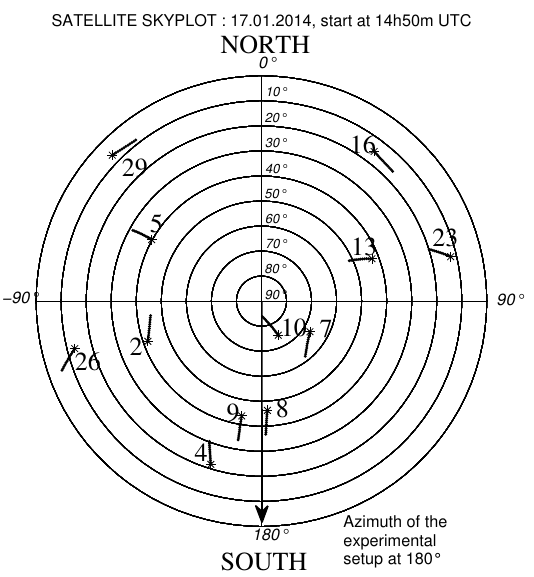
Figure 13. Trajectories of the satellites in view during the measurements on 17 January 2014, at 14h50